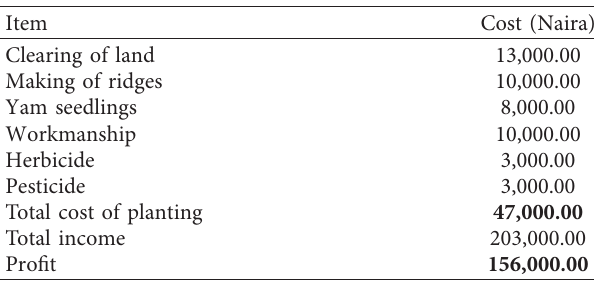
Table 3: Dominion farm, Ife, Osun State, Nigeria (cost of planting yam per acre).